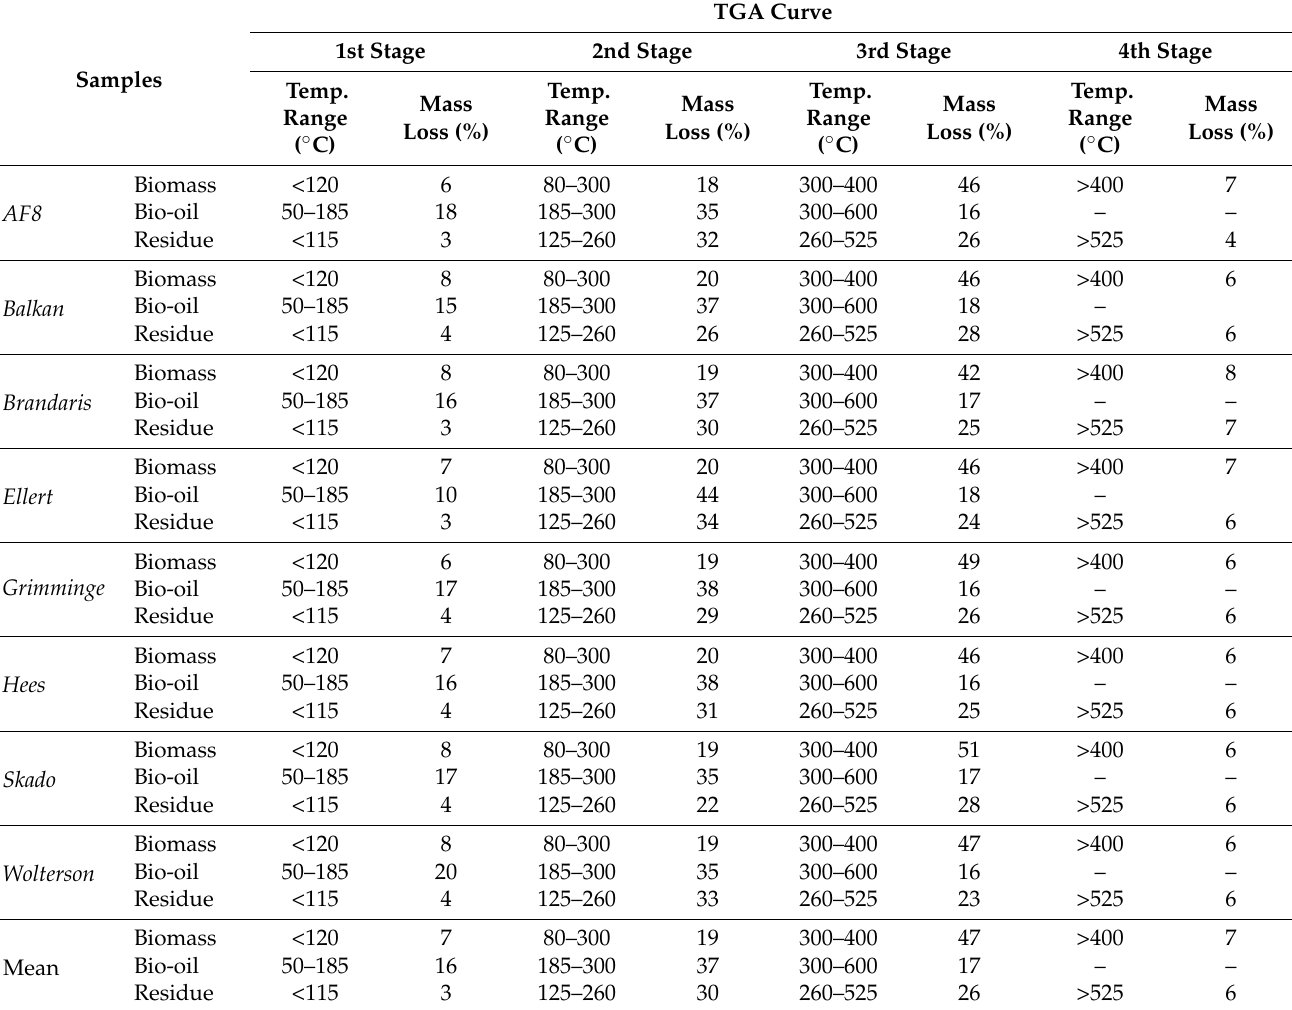
Table 6. Mass loss from TGA curves for biomass, bio-oils, and solid